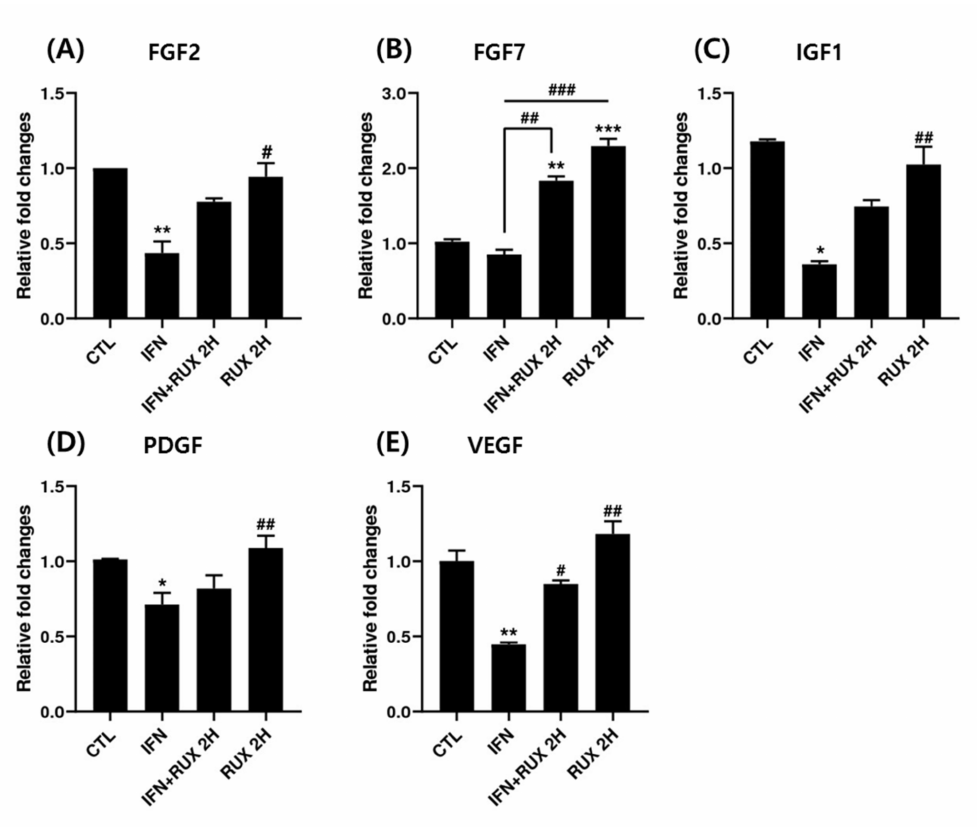
Figure 5. E ff ects of ruxolitinib treatment on hair-growth-related growth factors. Ruxolitinib significantly upregulated the mRNA of various growth factors including ( A ) FGF2, ( B ) FGF7, ( C ) IGF1, ( D ) PDGF, and ( E ) VEGF, which was suppressed by IFN- γ . The data represent the means ± SEM, n = 3, statistically significant at * p < 0.05, ** p < 0.01, *** p < 0.001, compared to the control and # p < 0.05, ## p < 0.01, ### p < 0.001 compared to the IFN- γ -treated